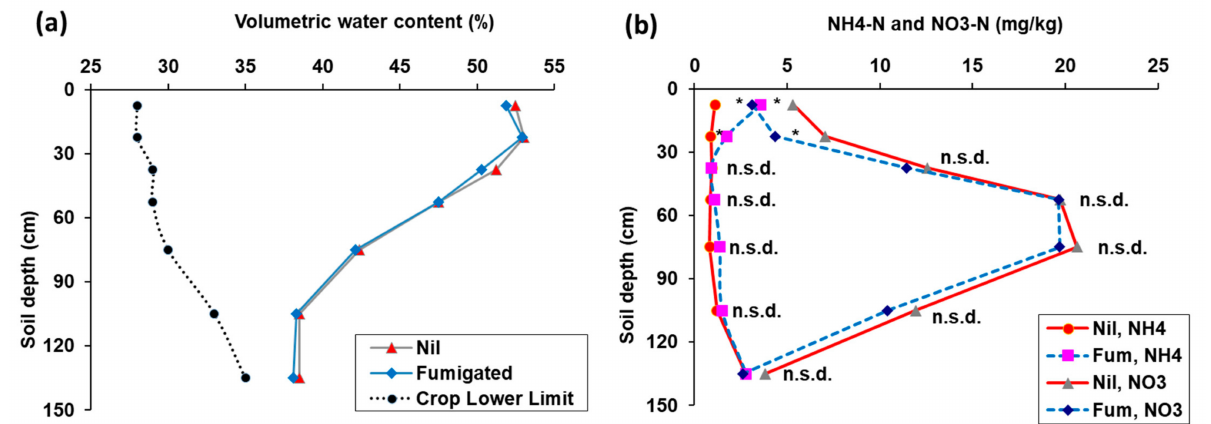
Figure 12. Effect of fumigation with methyl bromide on ( a ) volumetric water content and ( b ) mineral nitrogen (ammonium and nitrate) in the soil profile before sowing Experiment 4. Points are the means ( n = 15), where significant difference between nil and fumigated treatments at the respective depth interval is represented as * = p < 0.05. There were no significant effects of fumigation or of the interaction of fumigation and soil depth for volumetric water content in